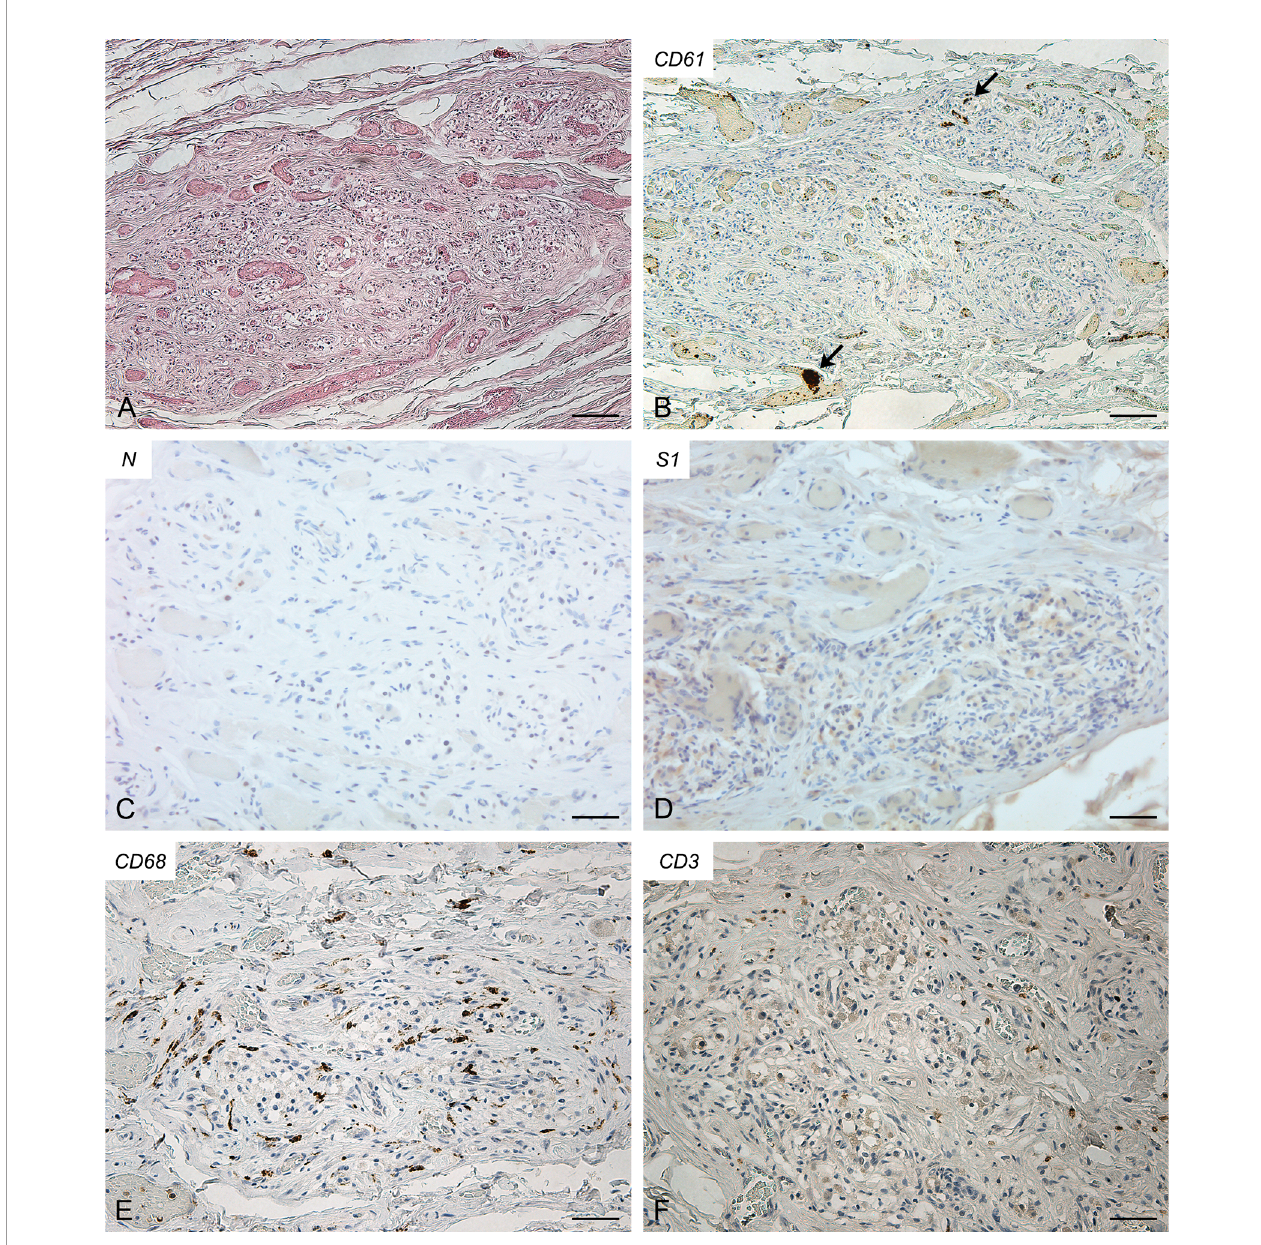
FIGURE 1 | Right carotid body of Case 1 – Haematoxylin-eosin (A) and immunohistochemitries for CD61 ( B ; arrows: fi brin/platelet microthrombosis), nucleocapsid (C) , Spike (D) , CD68 (E) and CD3 (F) . Scale bars: 100 µm (A, B) ; 50 µm (C – F)